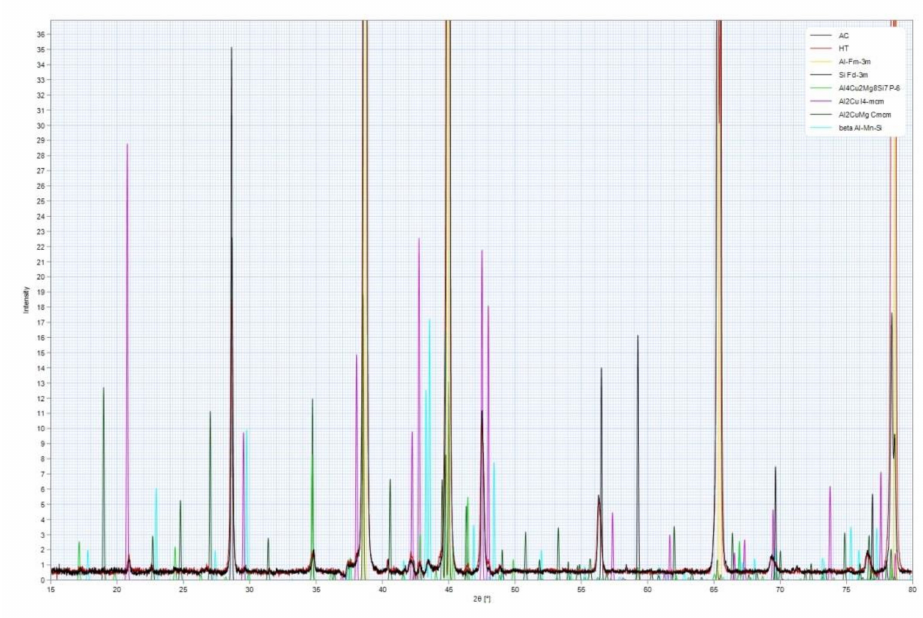
Figure 8. XRD patterns of bulk AlSi7MgCu